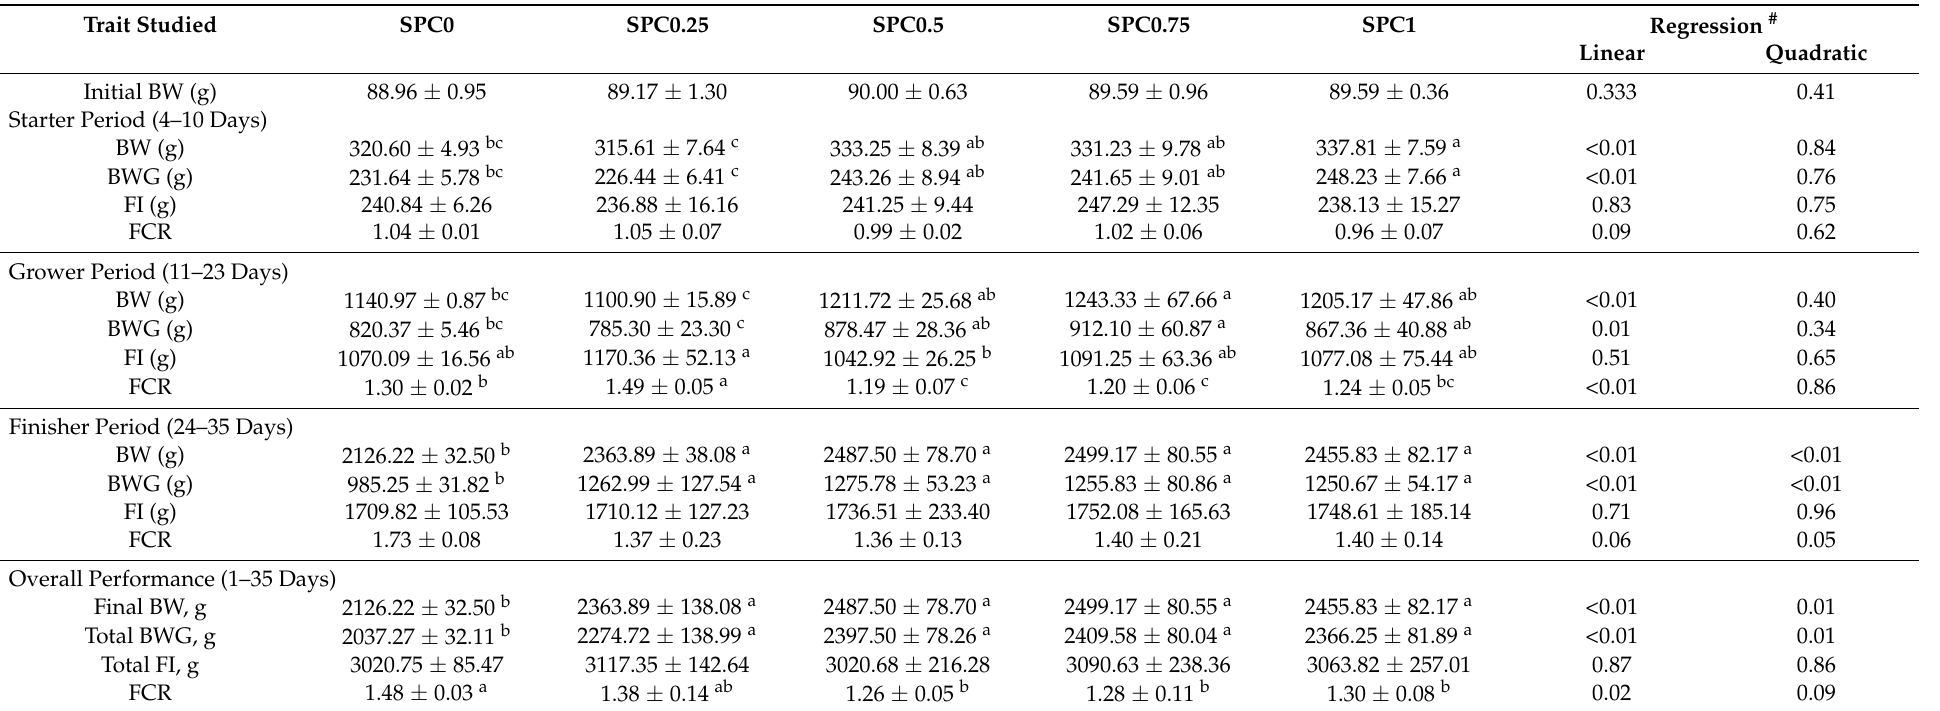
Table 2. Effects of dietary Spirulina platensis phycocyanin on the growth performance of broiler